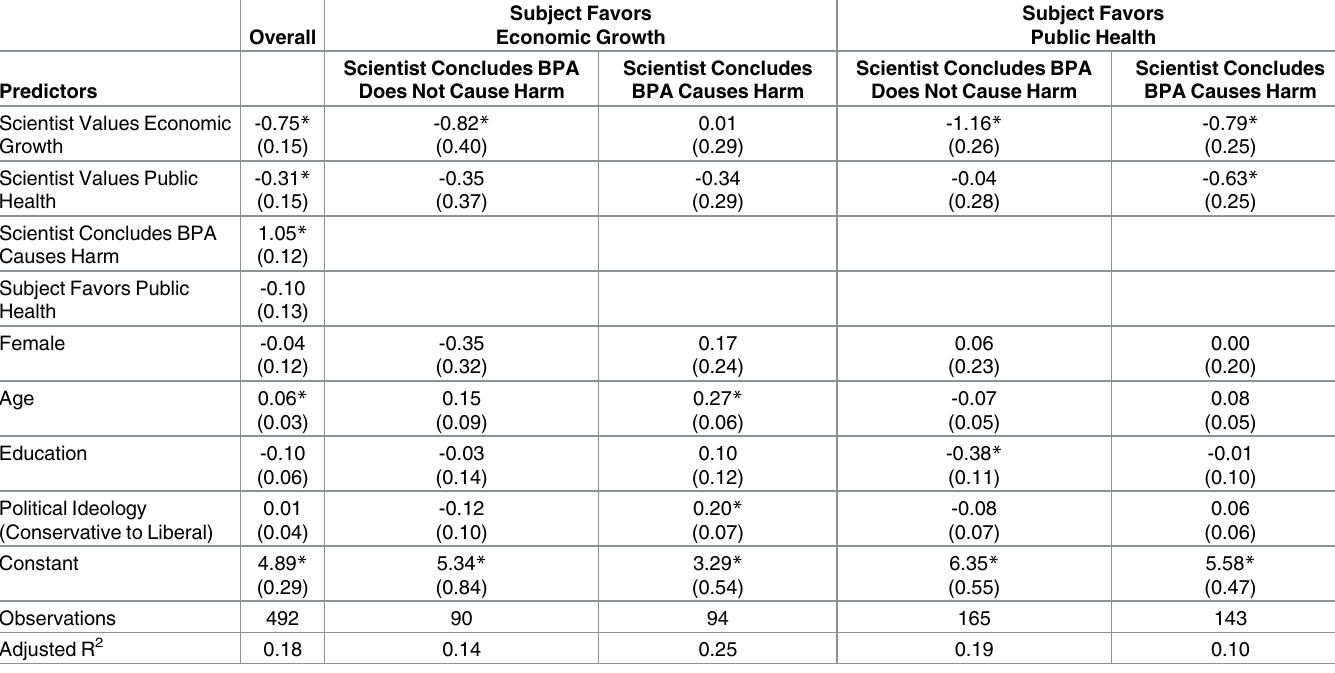
Table 1. Measuresof the effect of scientists’ conclusions and expressedvalues on respondents’ positive attitude toward them (Experiment